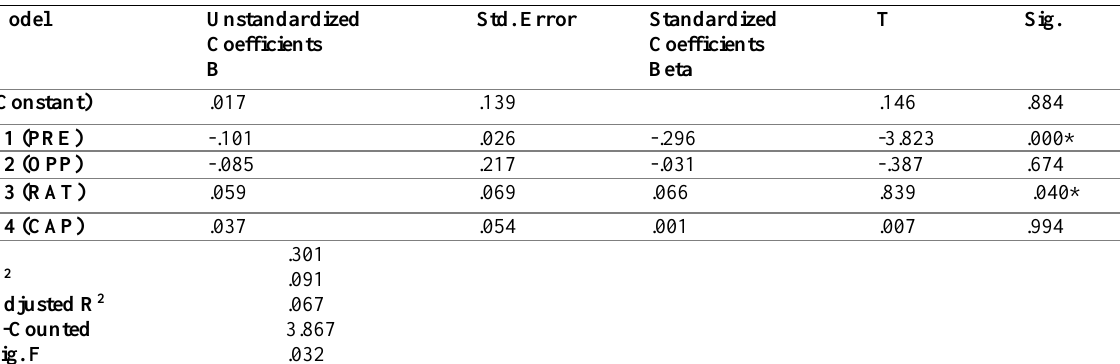
Table 2: Result of Multiple Linear Regression Analysis